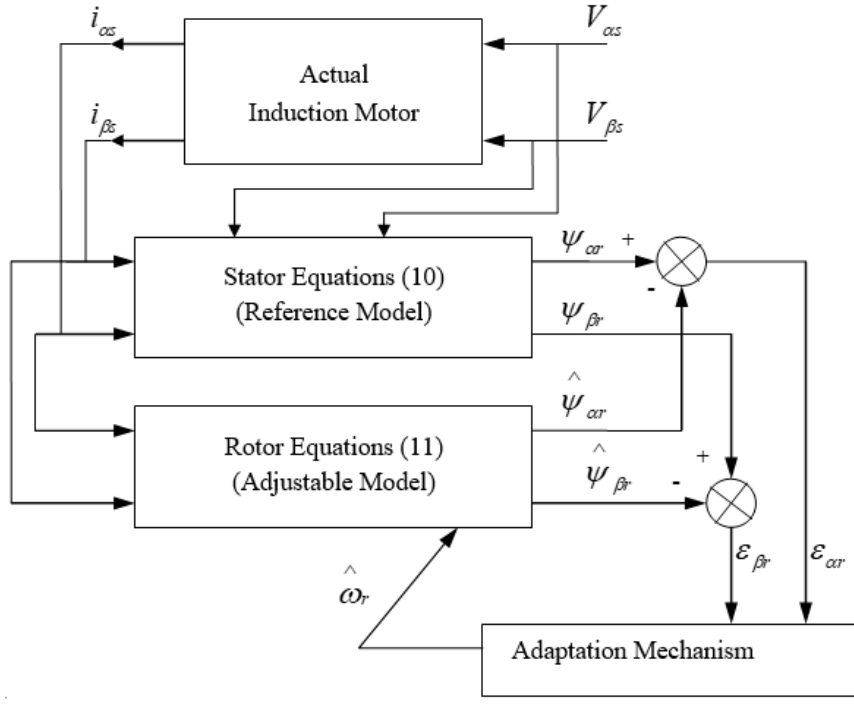
Figure 5. Structure of the MRAS system for motor speed estimation.